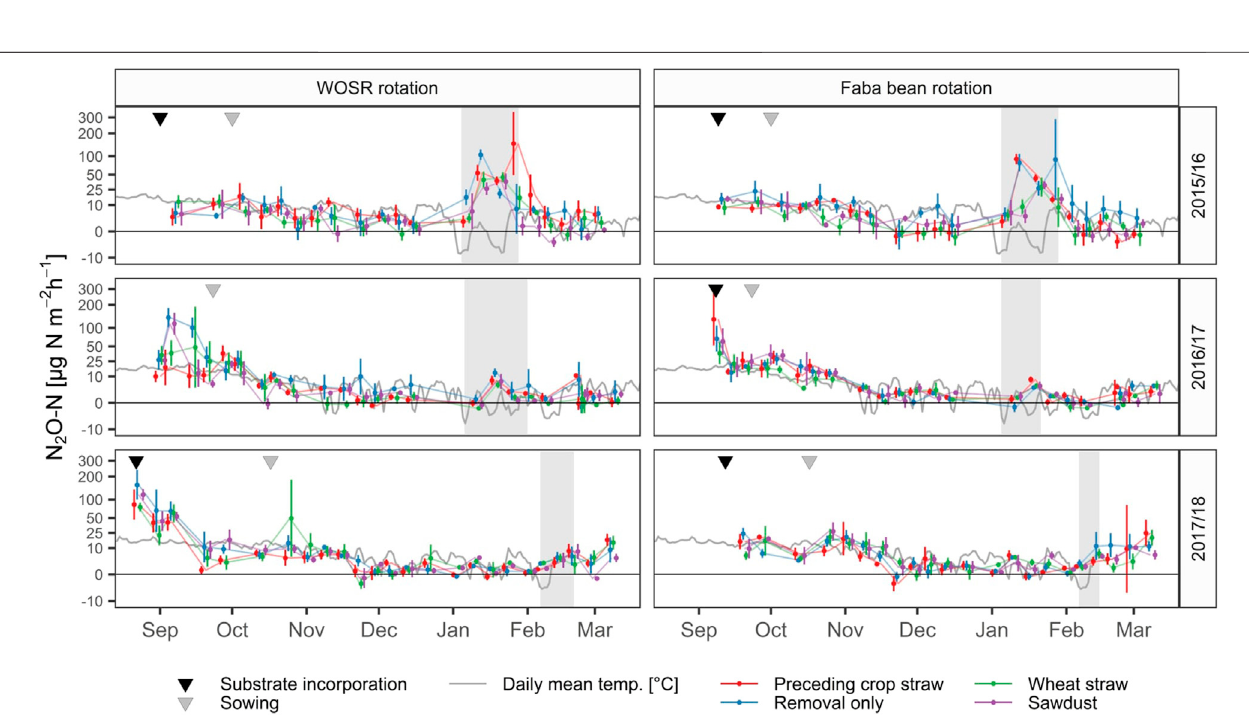
Frontiers in Environmental Science |